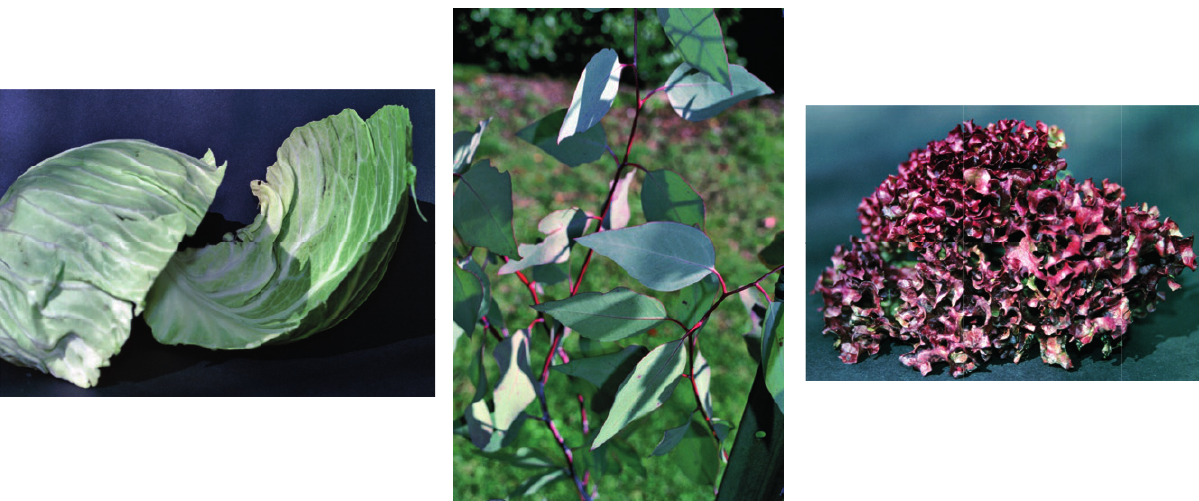
Figure 17. (L to R): Cabbage (elliptic), eucalyptus (parabolic) and lettuce (hyperbolic) leaves with positive, zero and negative